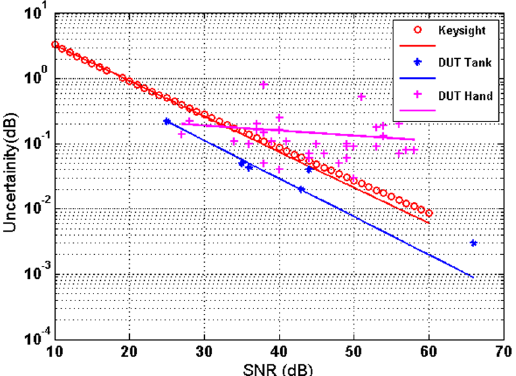
Figure 3. Measurement uncertainty as a function of SNR: Different devices under test using the Keysight E8361A VNA. For the case of glucose-loaded water-based samples and hand, the SNR is calculated by dividing the received signal at port by the noise floor provided by Keysight from characterization data sheet.